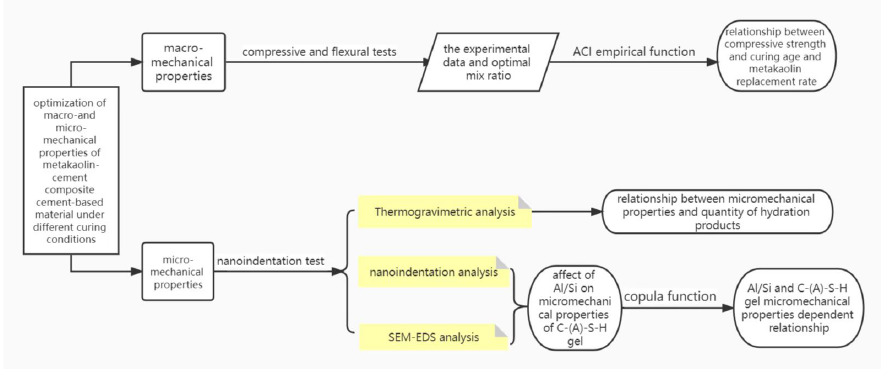
Figure 1. The research content and test procedure.